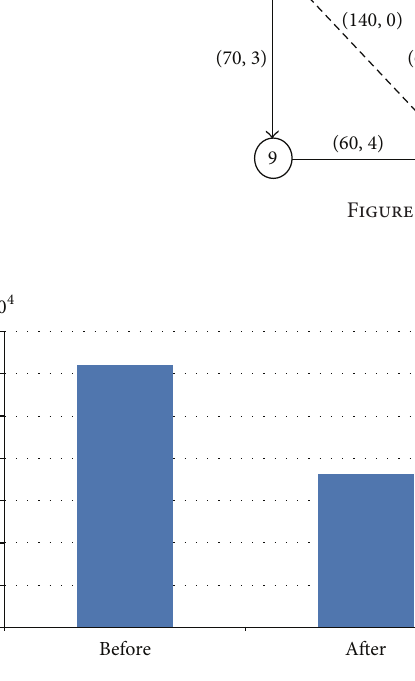
Figure 5: Objective value of upper model versus iteration number of